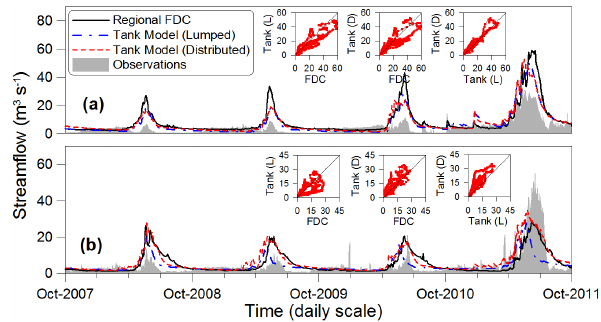
Fig. 7. Simulated streamflow in regulated watersheds: (a) Sevier River near Kingston, and (b) Sevier River near Gunnison. FDC, Tank (L), and Tank (D) of the inside 1:1 plots are streamflows in m 3 s − 1 simulated by the FDC method, lumped tank, and semi- distributed tank models, respectively.